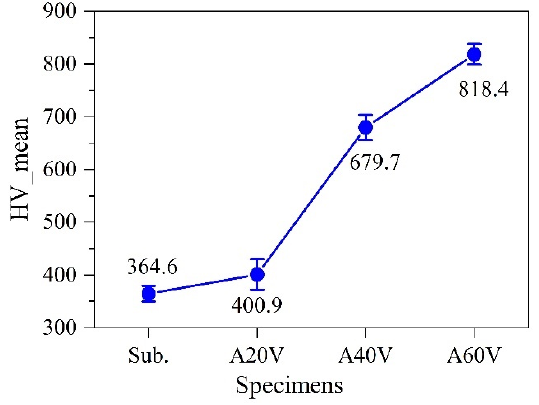
Figure 4. Mean surface microhardness of various specimens.